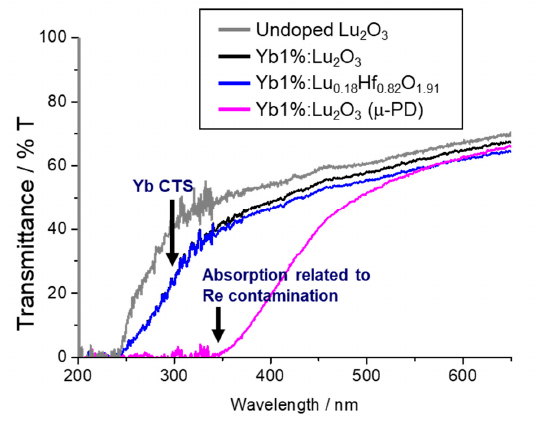
Figure 7. In-line transmittance of the CH-grown undoped Lu 2 O 3 , Yb1%:Lu 2 O 3 , and Yb1%:Lu 0.18 Hf 0.82 O 1.91 , in comparison with μ -PD-grown Yb1%:Lu 2 O 3 .